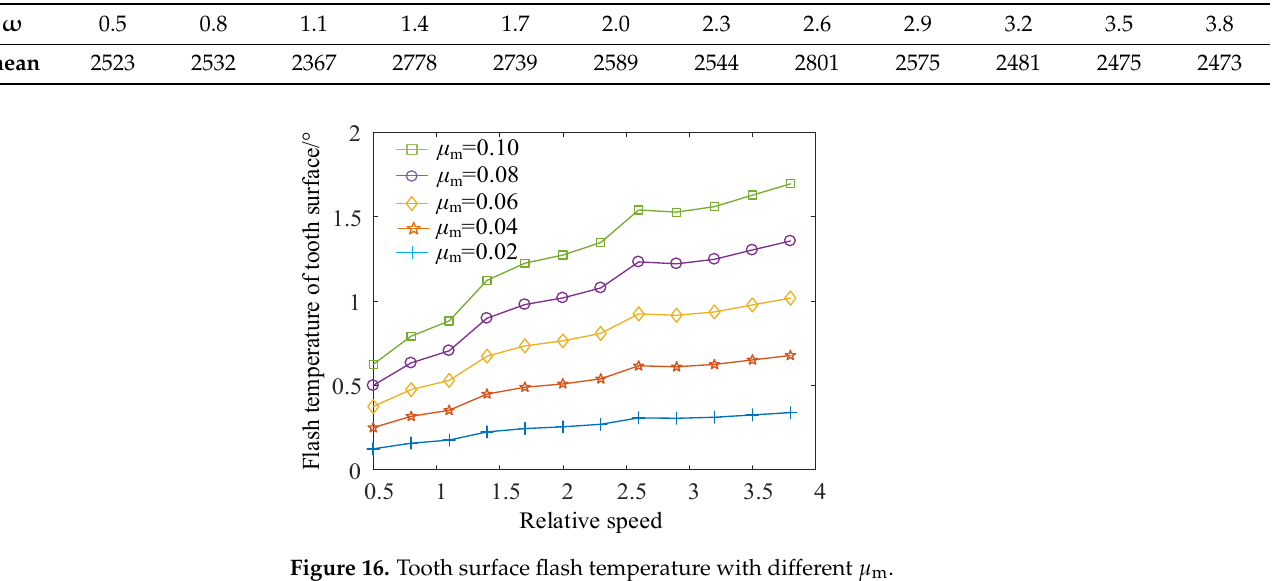
system, and different lines represent the tooth surface flash temperature with different